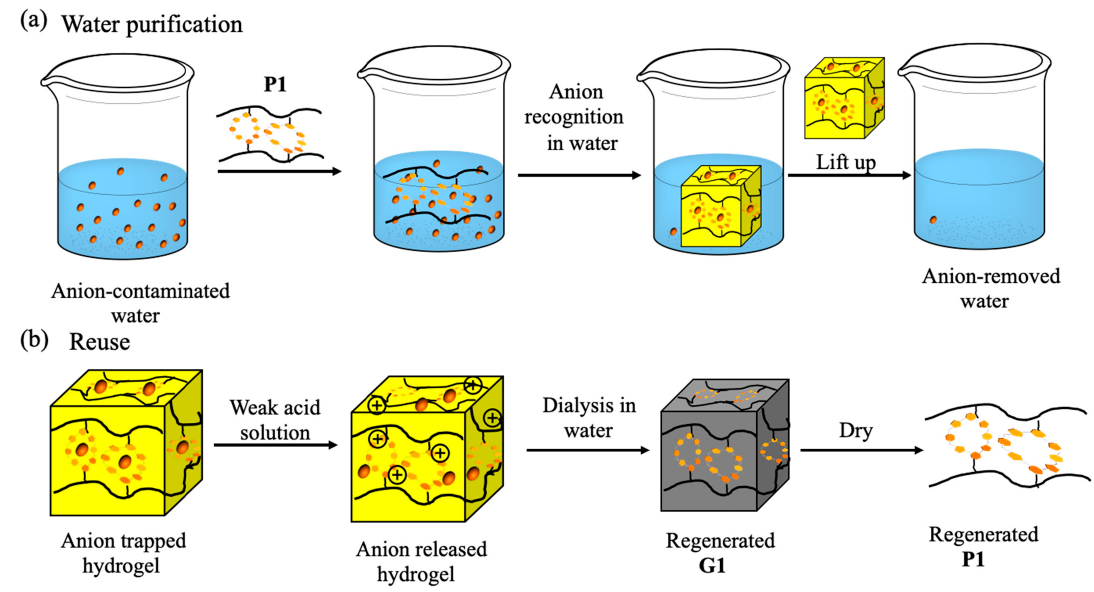
Figure 9. ( a ) Anion removal from a simulated contaminated aqueous source phase by use of a polymeric network P1 containing a TxSB derivative that serves as a tetracationic macrocyclic anion receptor. ( b ) Regeneration of P1 by means of dialysis to give G1. Reproduced from ref [55]. Copyright 2018 American Chemical Society.